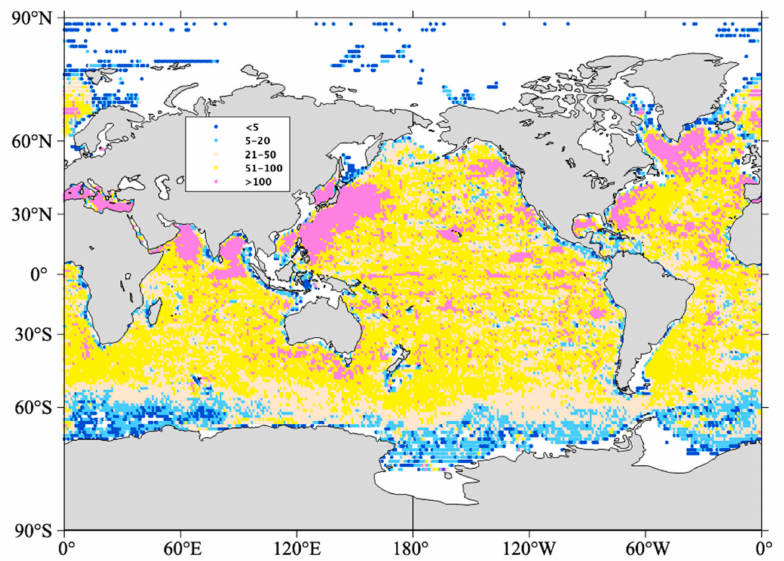
Figure 1. Number of Argo profiles within 1 ◦ × 1 ◦ boxes from 1 January 2004 to 31 December 2020 in the global